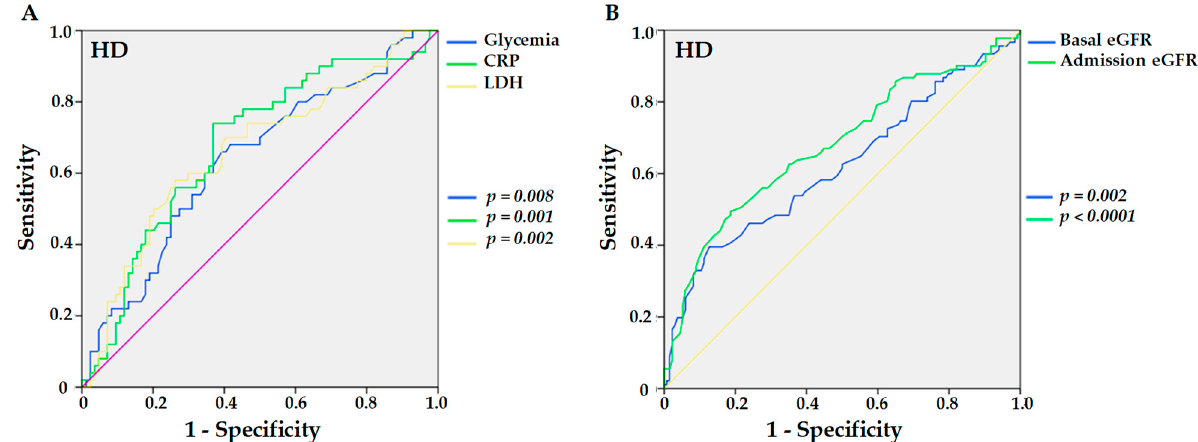
Figure 3. Sensitivities and specificities of higher levels of previous glycemia ( p = 0.008), C-reactive protein (CRP, p = 0.001), and lactate dehydrogenase (LDH, p = 0.002) ( A ), and lower levels of eGFR at baseline ( p = 0.002) and at admission ( p < 0.0001) ( B ) in hypertensive kidney transplant recipients with COVID-19 for the outcome of the need for hemodialysis (HD).